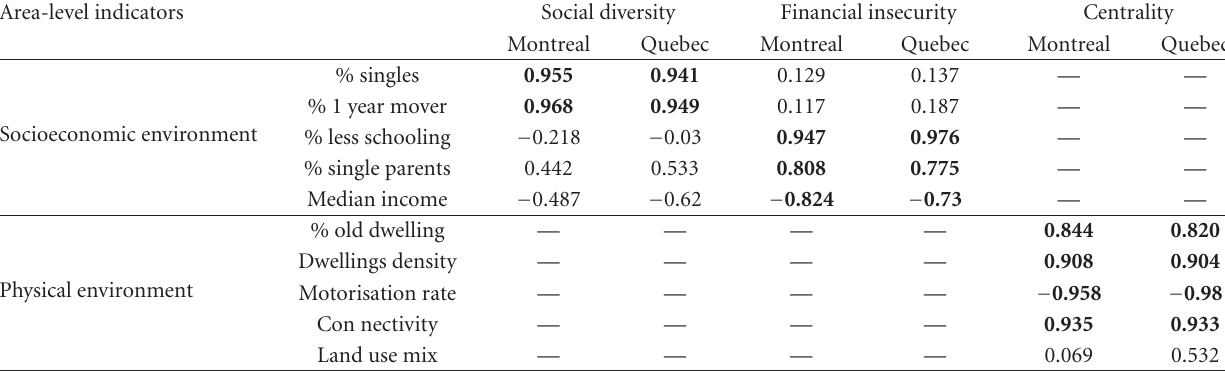
Table 2: Principal components loadings for the socioeconomic and physical environments in Montreal and Quebec